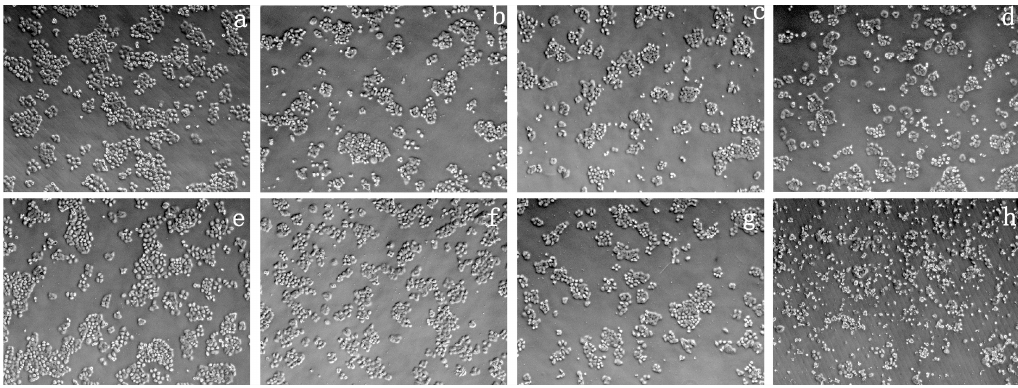
Figure 6. Performance of human hepatic cells (LO2) treated with various concentrations of AR and AR-OMCS: ( a ) control AR; ( b ) 0.25 g/L AR; ( c ) 0.5 g/L AR; ( d ) 1 g/L AR; ( e ) control AR-OMCS;